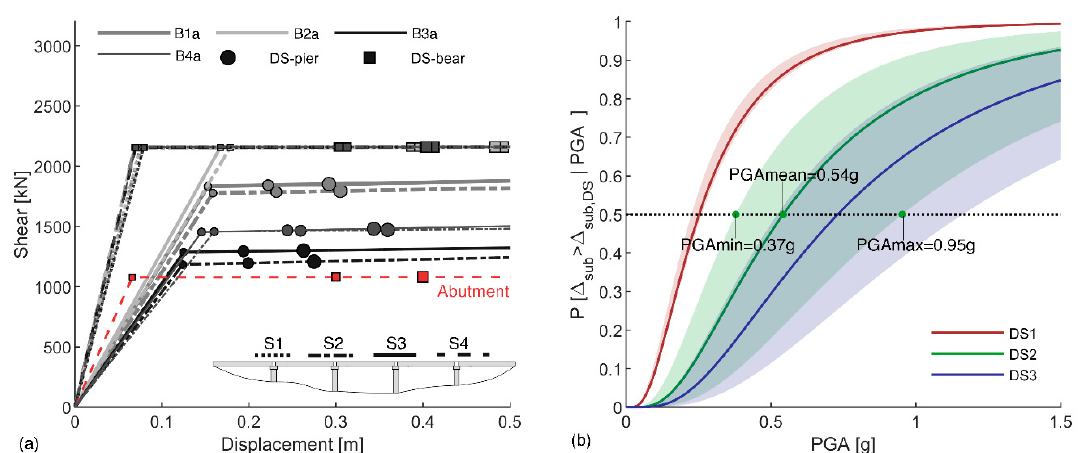
Figure 9. ( a ) Force displacement laws of the subassemblies of B1a, B2a, B3a, B4a ( ρ t = 0.09%). The subassemblies are indicated with a different line pattern, the index ‐ bridges with different colors and linewidth. ( b ) Bundles of fragility curves of the main bridge